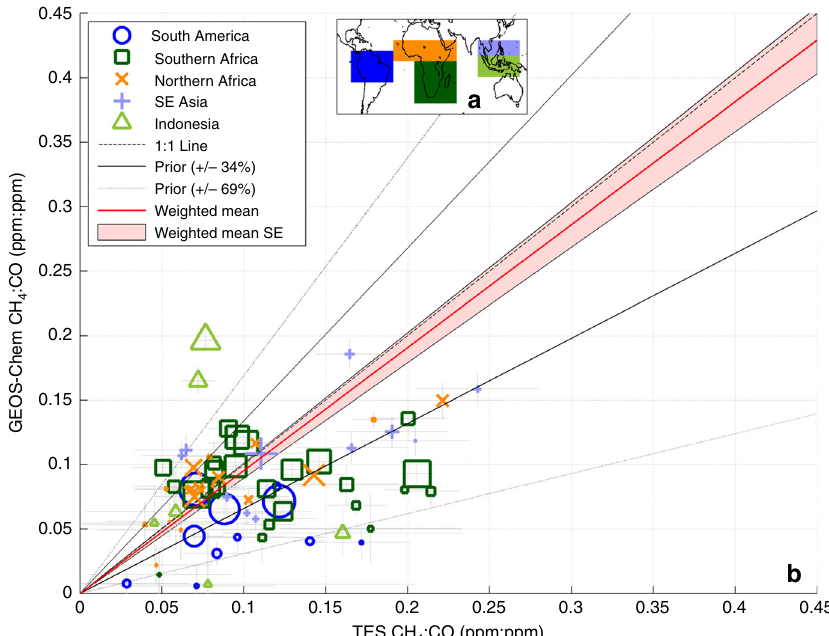
Fig. 6 Comparison of CH 4 /CO ratios from the GEOS-Chem model and Aura TES data. a Comparison of CH 4 /CO ratios observed in tropical and sub- tropical fi re plumes from the Aura TES data to those expected from the GEOS-Chem model with GFED-based emission factors. b The regions corresponding to symbols in a . The best fi t (weighted to the size of the fi re emissions) and the corresponding standard error (standard error or the pink- shaded area in fi gure) are shown by the red line and shaded area. Fires from different regions are shown as different symbols. The relative size of the fi re emissions is indicated by the relative size of the